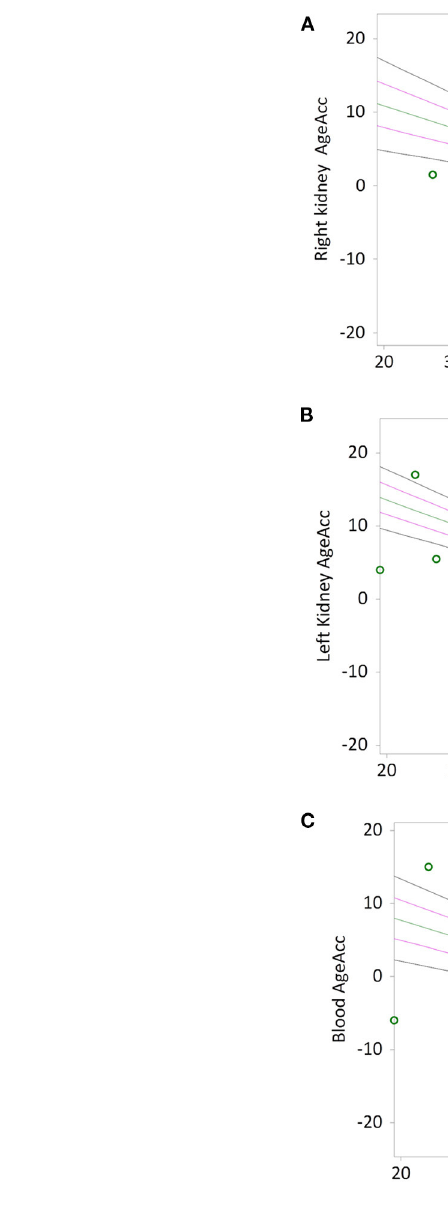
FIGURE 4 | AgeAcc of the right kidney, the left kidney, and blood leukocytes correlation with donors’ chronological age. In (A) and (B) , non-parametric linear regression plots showing the correlation between AgeAcc of RK and LK, and donors chronological age (Kendall’s rank correlation coefficient tau b for RK = − 0.483 and tau b for LK = − 0.638). In (C) , non-parametric linear regression plot showing the correlation between AgeAcc of the circulating blood leukocytes (indicated as “blood AgeAcc”) and the donors chronological age (Kendall’s rank correlation coefficient tau b = − 0.526). Mean, Standard Error (SE) and 95% coefficient intervals (CI) are represented as green, pink and black lines,